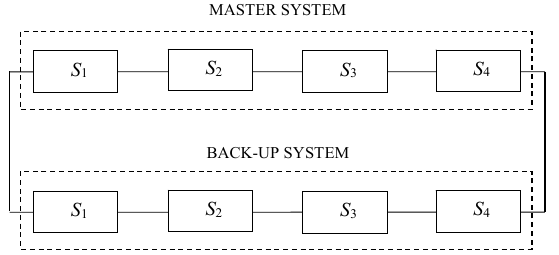
Figure 2. Reliability structure scheme of navigation system with one back-up system.